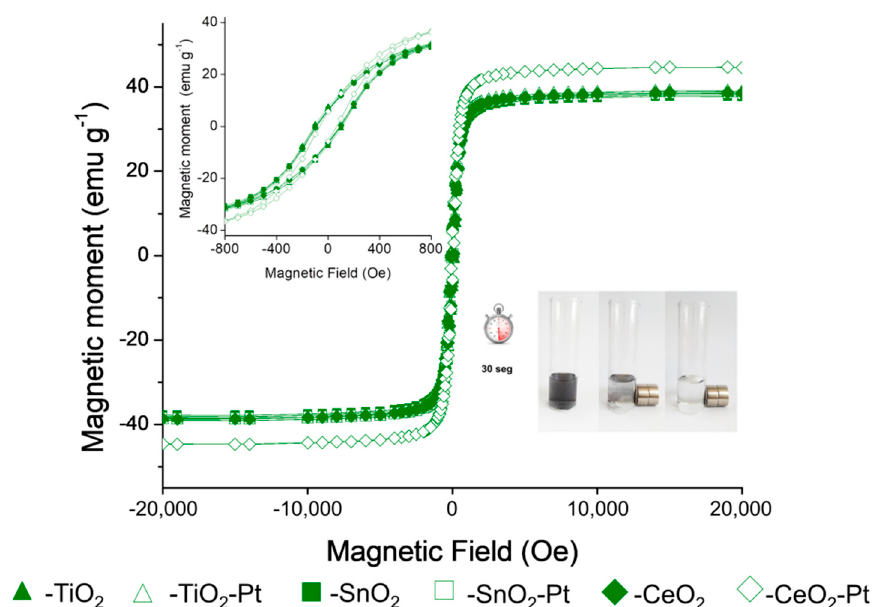
Figure 5. Magnetic measurements of Fe 2 O 3 –SiO 2 –MeO 2 and Fe 2 O 3 –SiO 2 –MeO 2 –Pt (Me = Ti, Sn, Ce) materials. Inset zoom of the hysteresis loop.